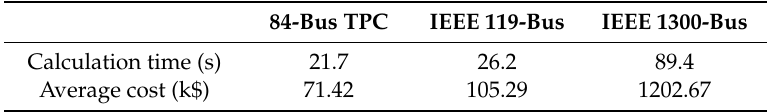
Table 3. Calculation time for large-scale test systems.